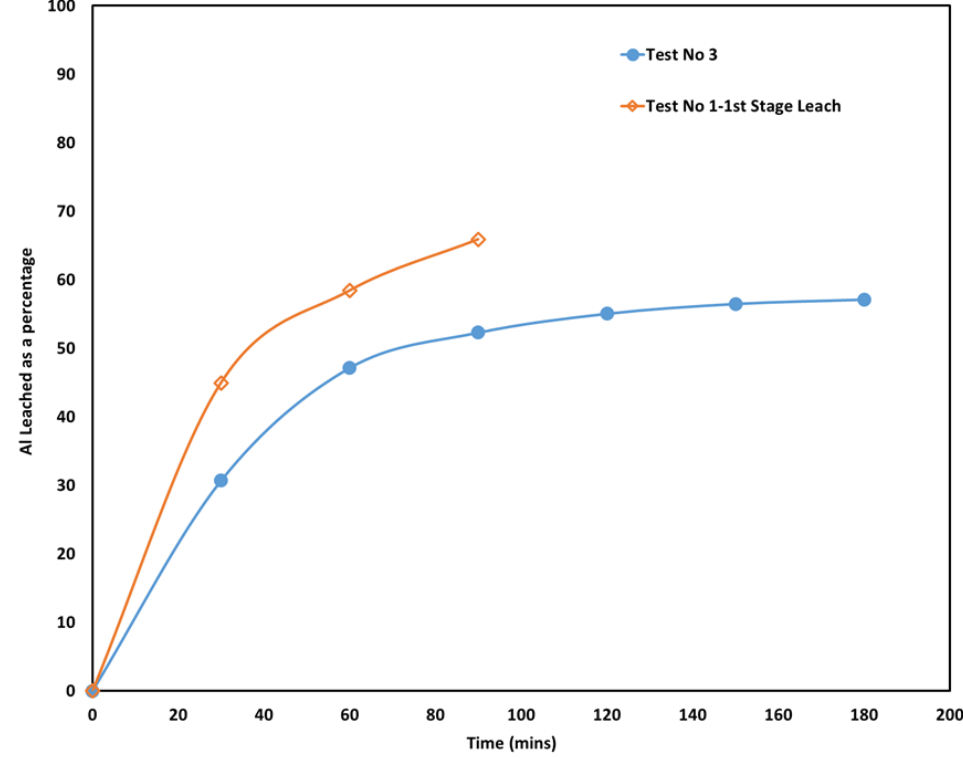
Figure 8. Test no. 3 leaching of 100 g of slag 1L of 60 g/L Na 2 CO 3. Figure 8 . Test no. 3 leaching of 100 g of slag 1L of 60 g/L Na 2 CO 3 . Figure 8 . Test no. 3 leaching of 100 g of slag 1L of 60 g/L Na 2 CO 3 .